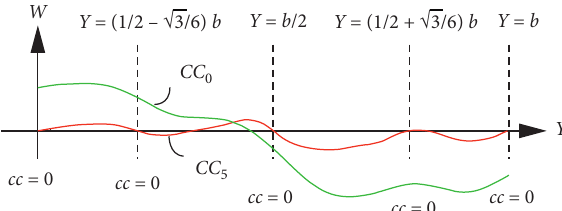
Figure 10: Residual error of the deformation in